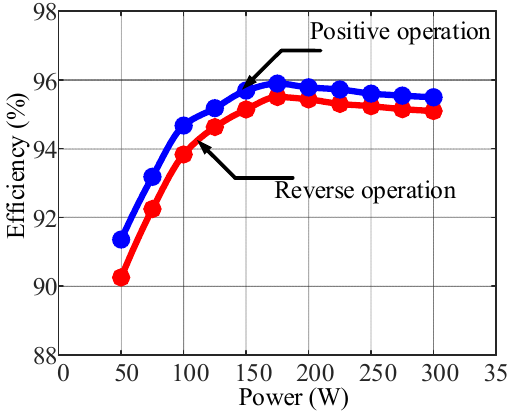
Figure 37. Efficiency curve.